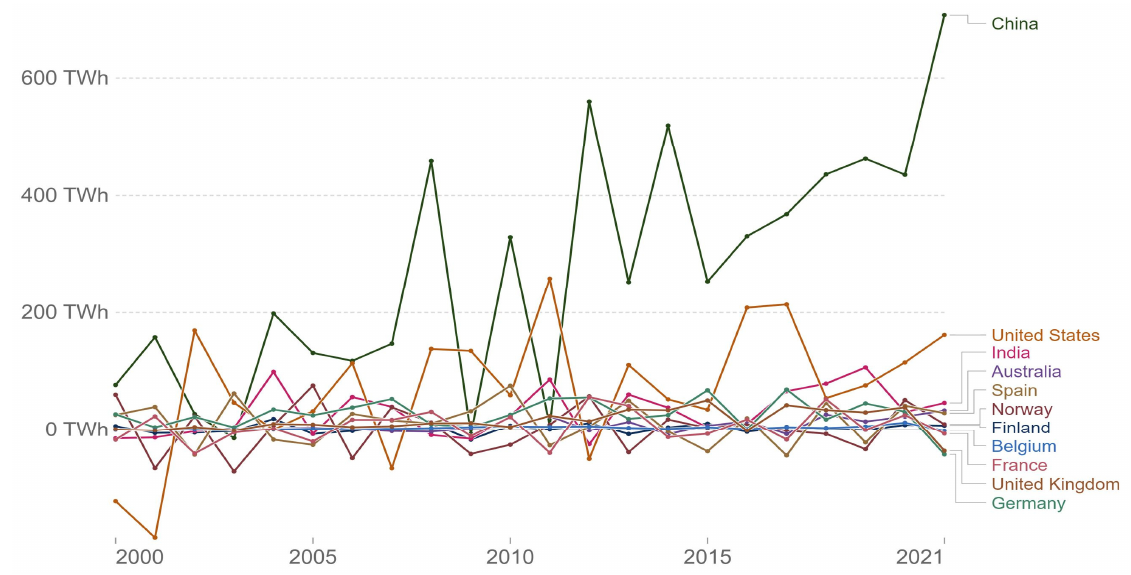
Figure 7. Annual change in renewable energy generation across different country [41].